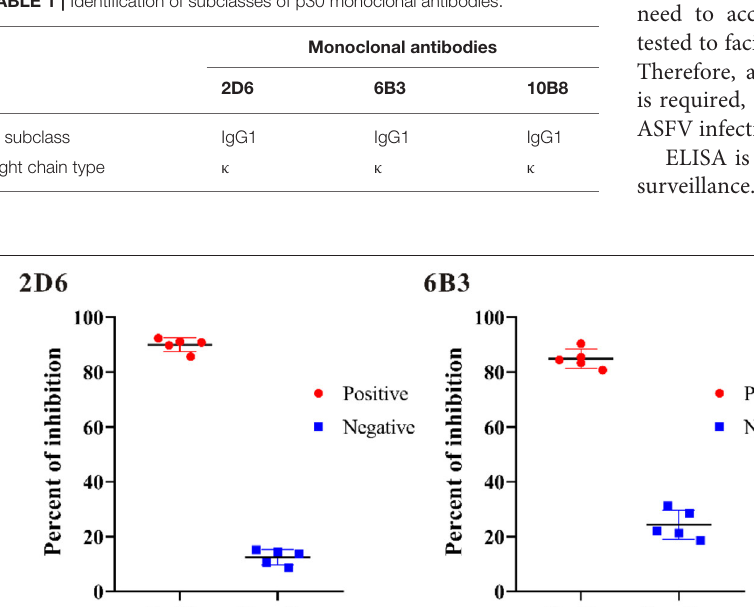
Frontiers in Veterinary Science |